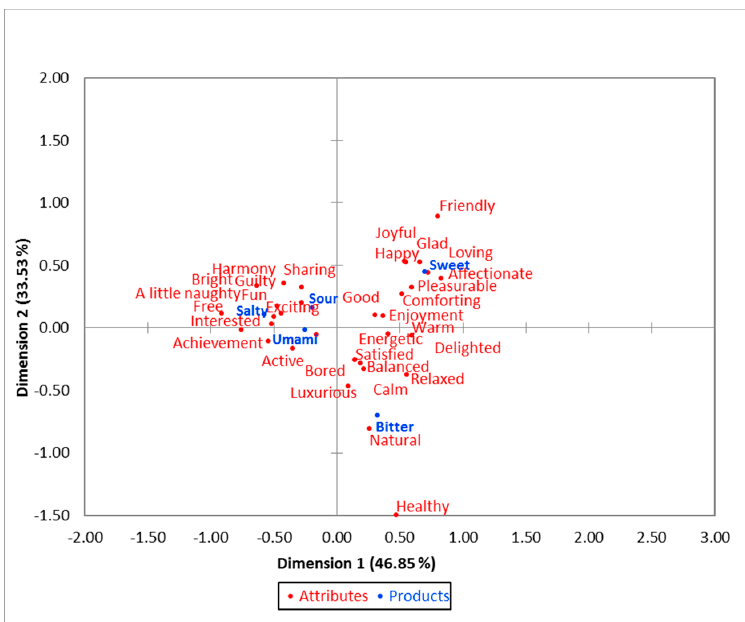
Figure 2. Correspondence analysis from the check ‐ all ‐ that ‐ apply test of the sensory session.